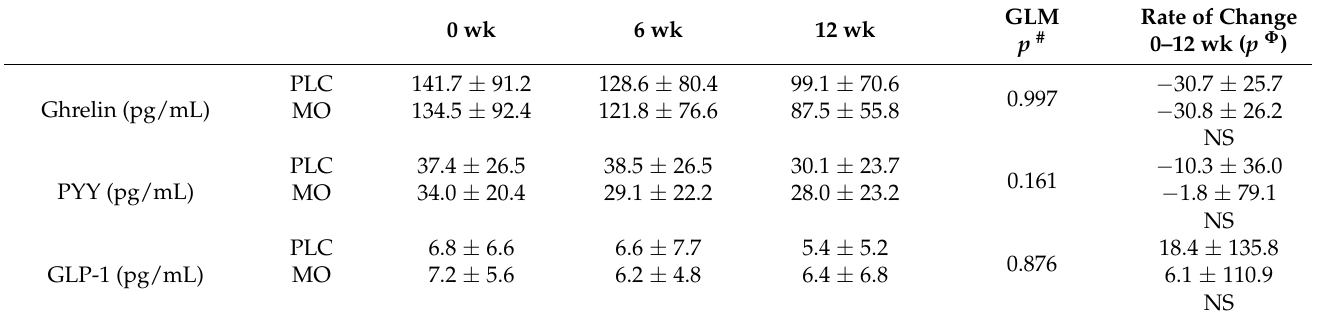
Table 5. Gut hormones in patients with prediabetes of the PLC and MO groups during the intervention.